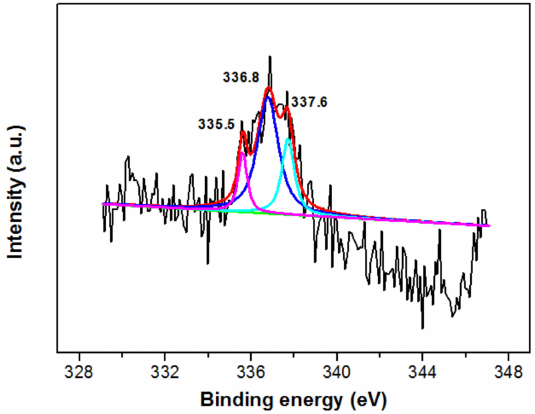
Figure 2. XPS spectra of the Pd 0 @MMT/PVP catalytic